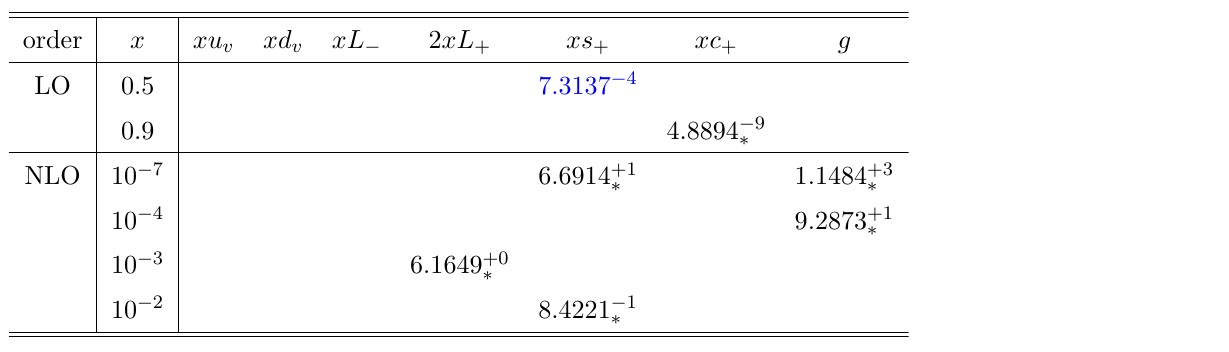
Table 2 Results for evolution with n F = 4 for which we differ from the numbers in the benchmark tables in Ref. [73]. The notation for PDF combinations is L ± = ¯ d ± ¯ u and q + = q + ¯ q for q = s , c . The number format a b is shorthand for a × 10 b . As discussed in the text, all differ-